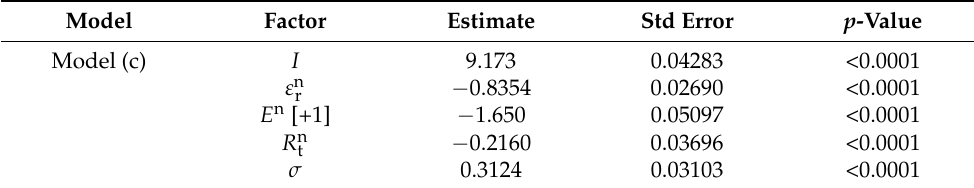
Table 7. Coefficients for a reduced model including only the main effects. Note that the normalized versions of the factors need to be used (Table 5); in the case of the categorical variable E n the coefficient is 0 for E n = − 1, and the value in the table for E n = +1. Model